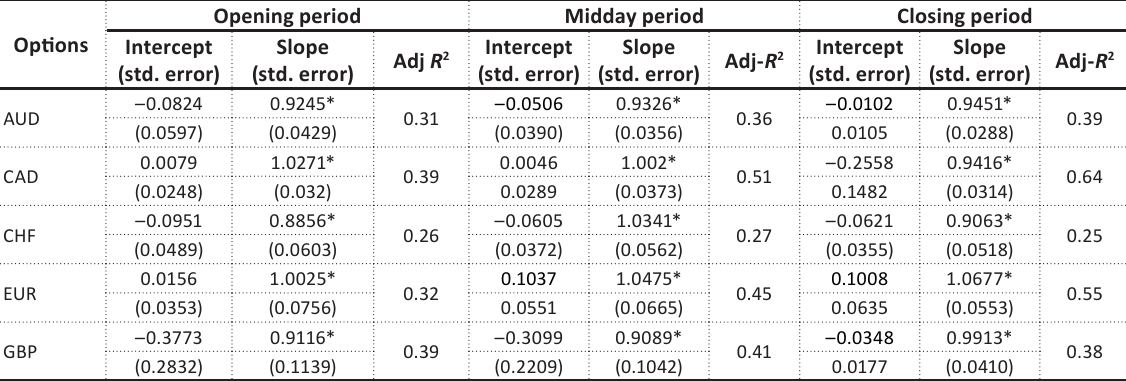
Table 1. Currency options market efficiency